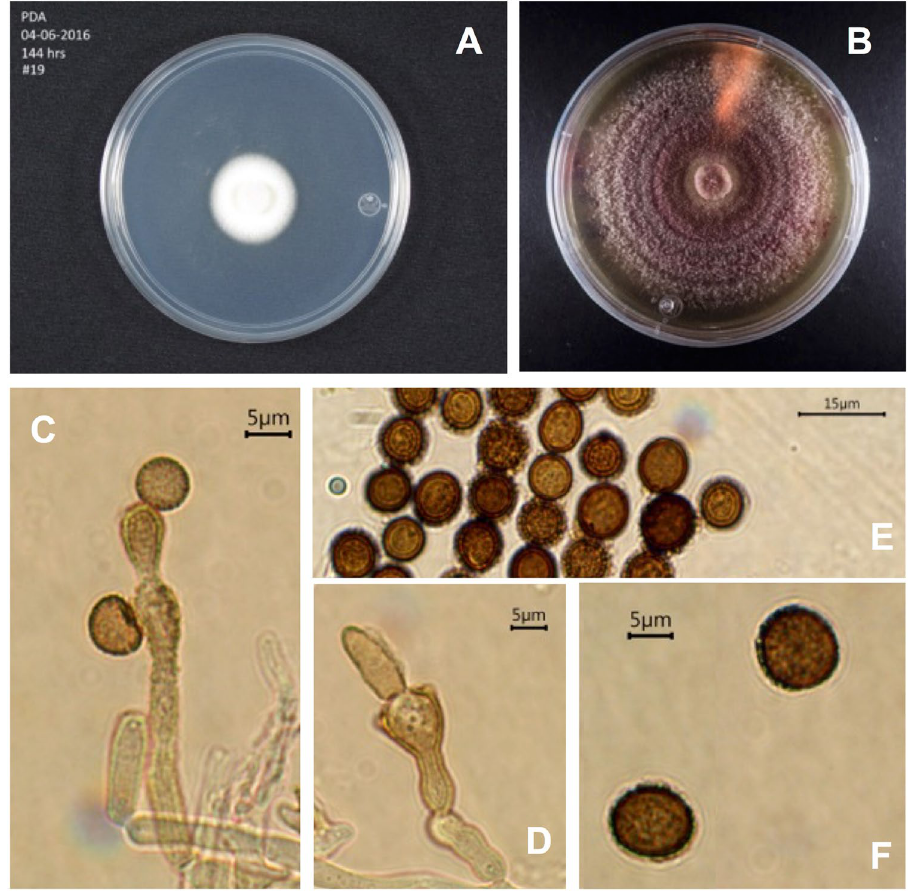
Figure 2. Periconia epigraphicola . ( A ) PDA Culture ca 6 days. ( B ), PDA Culture ca 20 days. ( C ) Conidiogenous cell forming conidia. ( D ) Conidiogenous cell. ( E ) Catenated spinulose conidia. ( F ) Spinulose